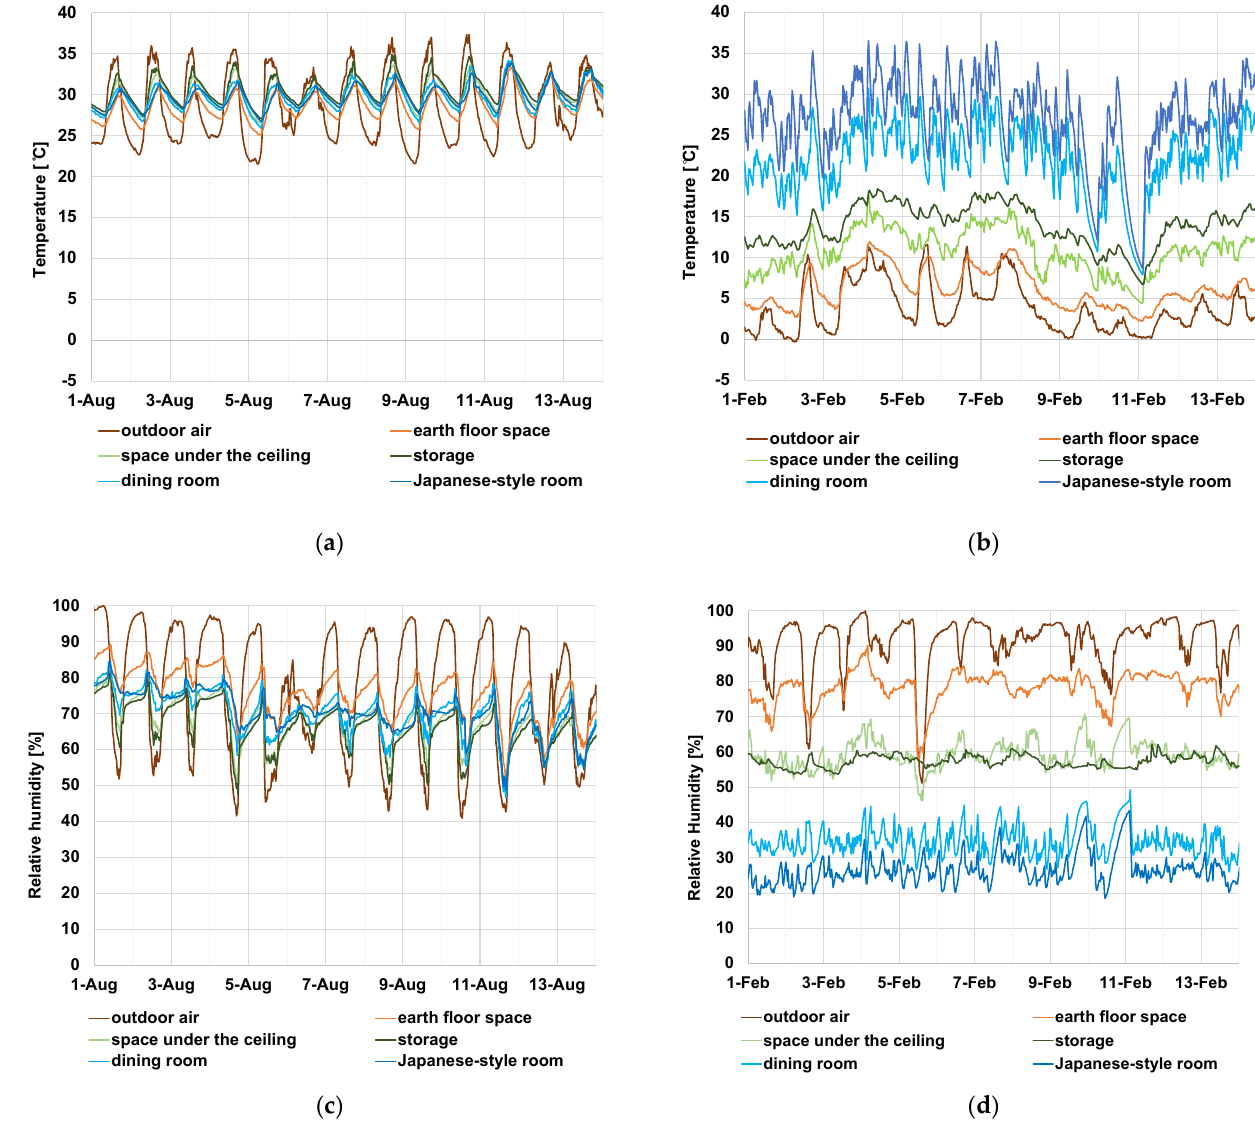
Figure 4. Measured value of temperature (°C)/relative humidity (%) in 2019. ( a ) Temperature in summer (1–14 August 2019), ( b ) temperature in winter (1–14 February 2019), ( c ) relative humidity in summer (1–14 August 2019), and ( d ) relative humidity in winter (1–14 February 2019).